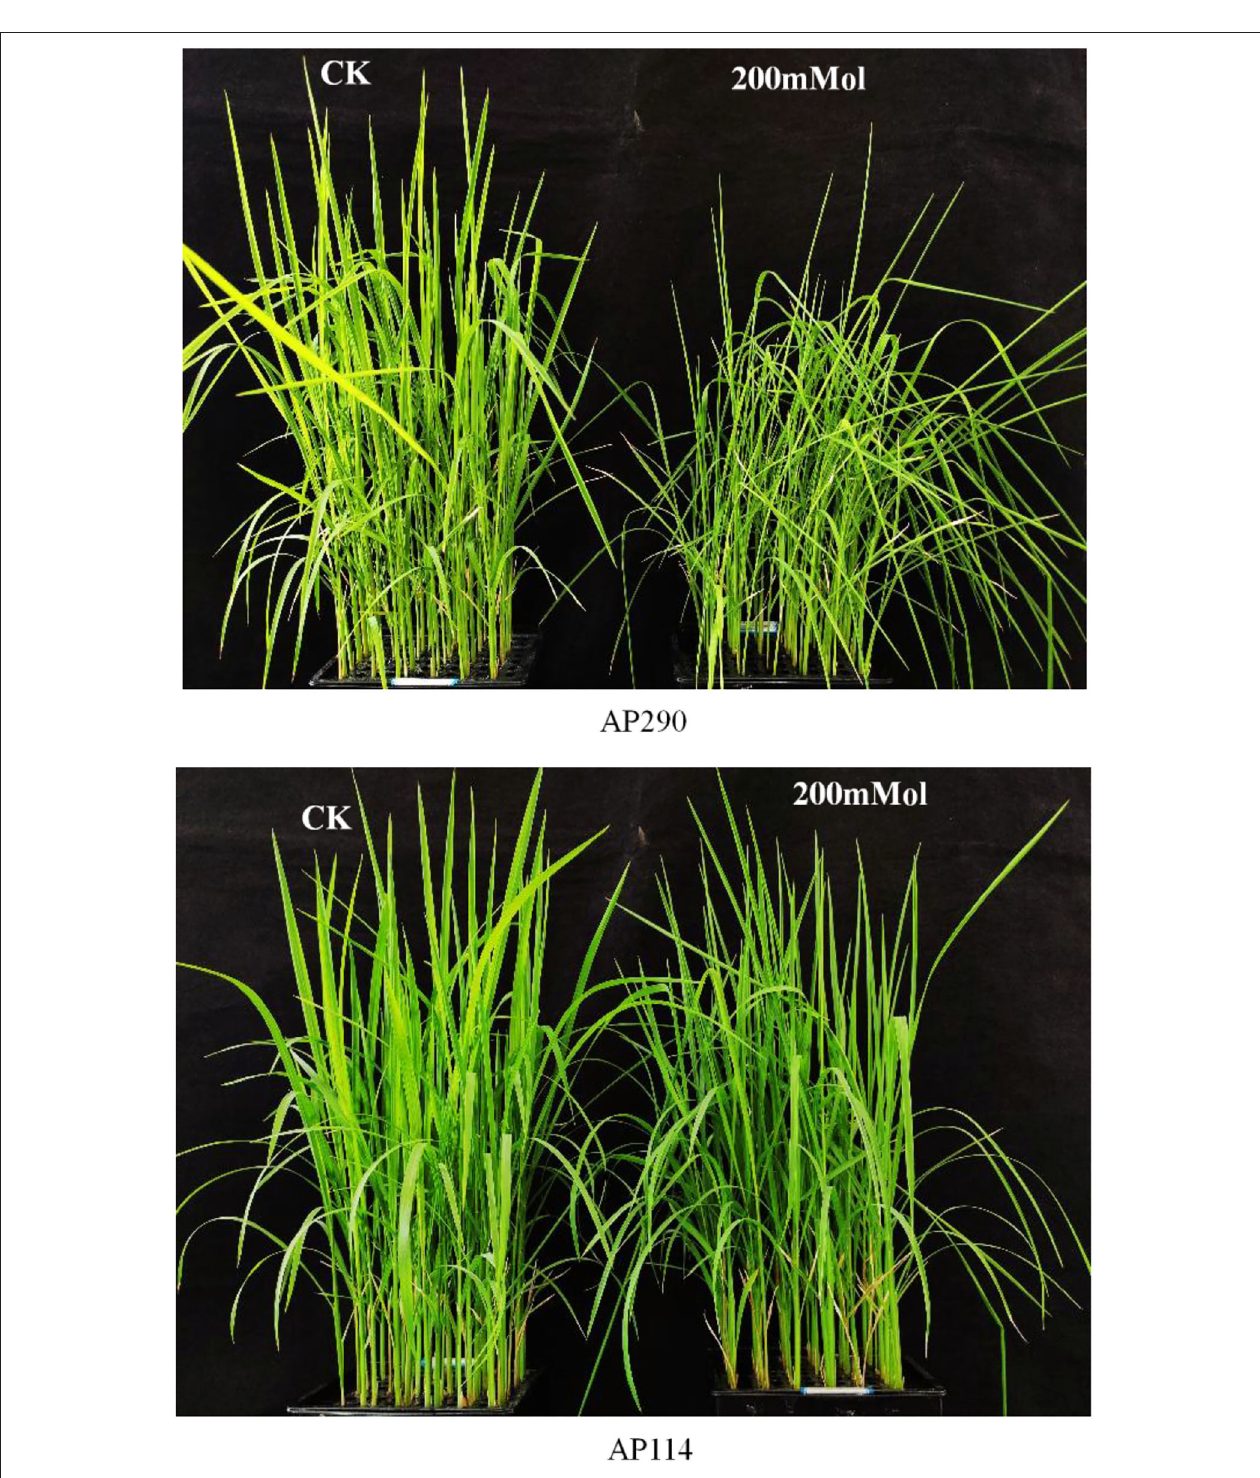
FIGURE 6 | Comparison of phenotypes between saline-treated plants and blank controls (CK).